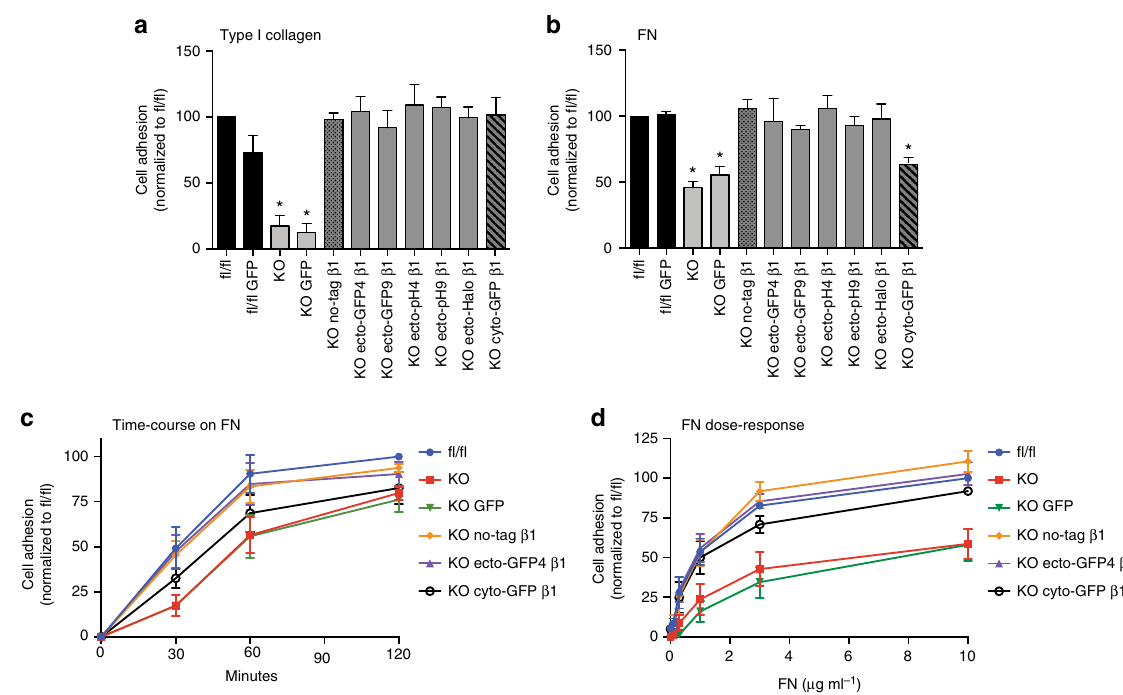
Fig. 3 Ecto-tagged β 1 integrins rescue the adhesion defect of β 1 integrin KO fi broblasts. a Adhesion of parental and reconstituted β 1 integrin fl / fl and KO fi broblasts 2 h after plating on wells coated with 3 μ g ml − 1 type I collagen. b Adhesion of parental and reconstituted β 1 integrin fl / fl and KO fi broblasts 1 h after plating on wells coated with 3 μ g ml − 1 FN. c Time course of adhesion of parental and reconstituted β 1 integrin fl / fl and KO fi broblasts on wells coated with 3 μ g ml − 1 FN. d Dose-response adhesion assay of parental and reconstituted β 1 integrin fl / fl and KO fi broblasts for 1 h to wells coated with increasing concentrations of FN. In all experiments, cell adhesion was measured by the absorbance at 570 nm after Crystal Violet staining. Data is shown as mean ± SEM from three independent experiments. In a , b , statistical analysis was performed using one-way repeated measures ANOVA with Dunnett post hoc test. Each column was compared to fl / fl and * p < the endoplasmic reticulum (ER). For this reason the ecto-SNAP β 1 integrin was not characterized further.